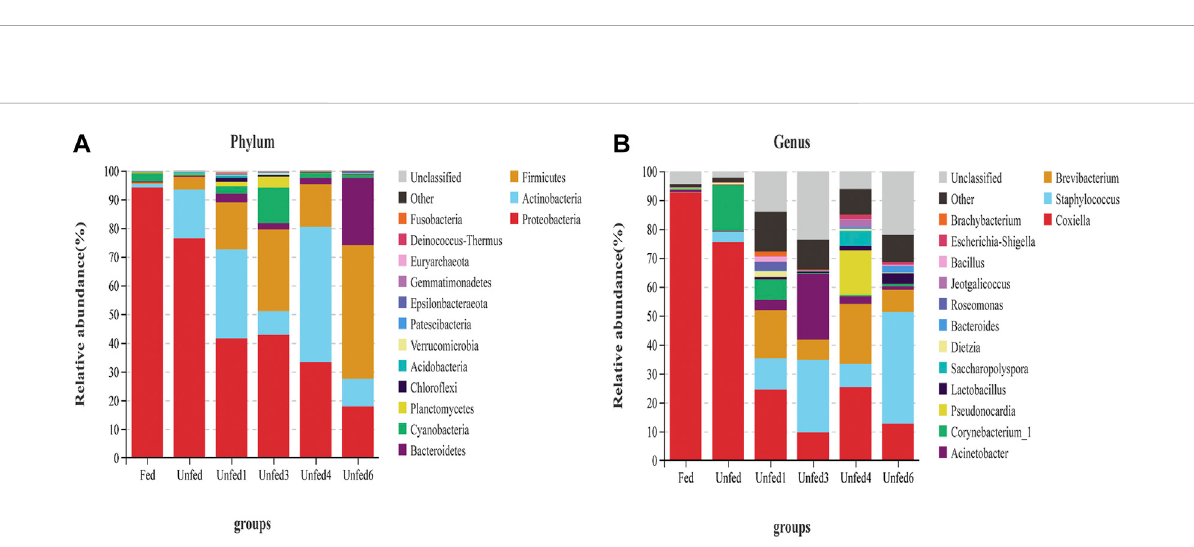
FIGURE 1 Diversity of gut microbial community as affected by starvation. Data from different groups were presented with different colors. Simpson (A) , ACE (B) , Shannon (C) , Sob (D) indices, OUT numbers (E) were shown in different panels. The group names were descripted in the Materials and Methods, and data from the three repeats in one group were shown separately. Note that since the correlation coef fi cient between the Unfed3-2 samples and the other two samples, Unfed3-1 and Unfed3-3, is low, this sample was excluded by the program before the analyses for the